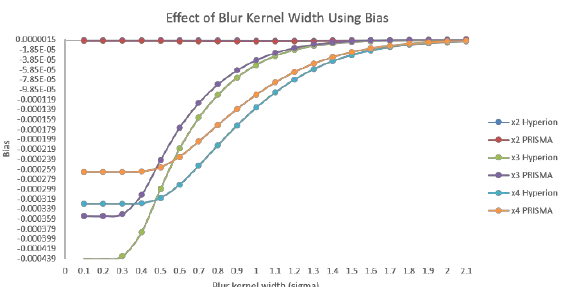
Figure 13. Effect of Blur Kernel Width Using RMSE on GPR’s Performance RMSE values are very low, though slightly higher than IBP. For x2 Hyperion and x2 PRISMA, there is a steep rise from σ = 0.7 onwards. Again σ = 0.1 shows the lowest RMSE for each SF irrespective of the dataset